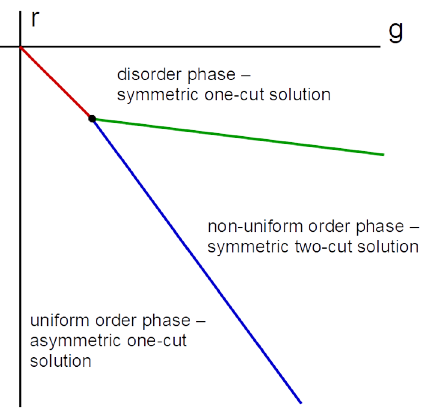
Figure 1 . A generic diagram of a noncommutative scalar field theory obtained in various numerical studies. The three transition lines meet at the black triple point. Commutative field theories lack the non-uniform order phase and the green transition line, standard matrix models without the kinetic term lack the uniform order phase and the blue transition